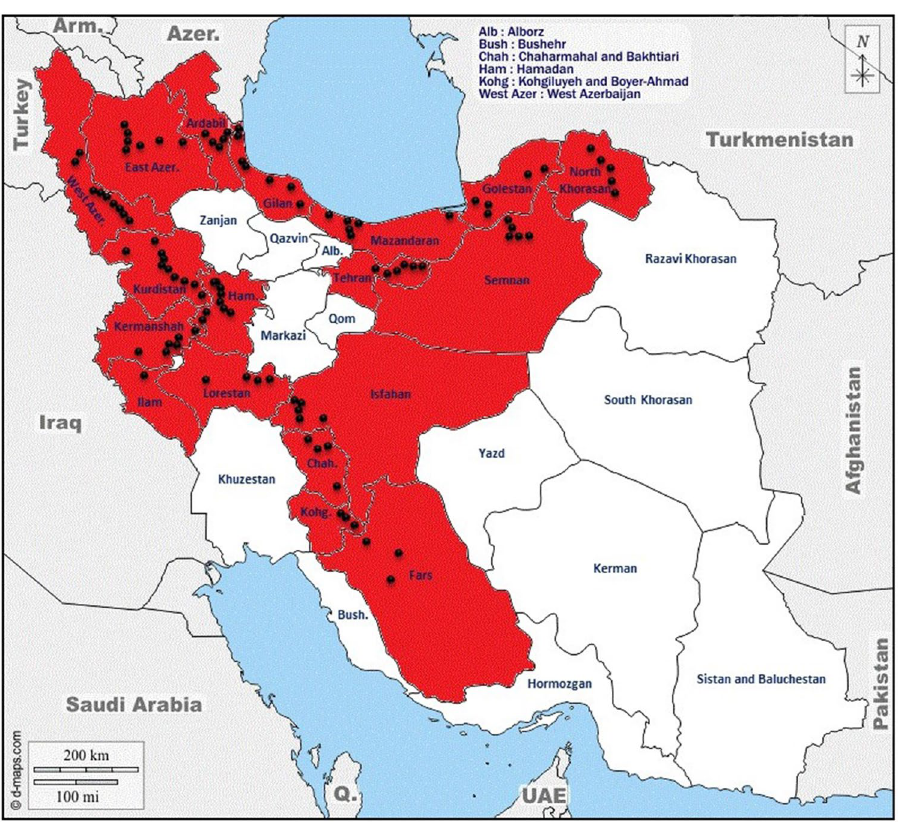
Figure 1. The collection areas of Poa pratensis accessions in Iran. The red color indicated provinces and the block circles represent the approximate location of the collected accessions. The original map obtained from d-map (https://d- maps. com/ carte. php? num_ car= 5496& lang= en) and modified (colored) using Adobe Photoshop CS6.